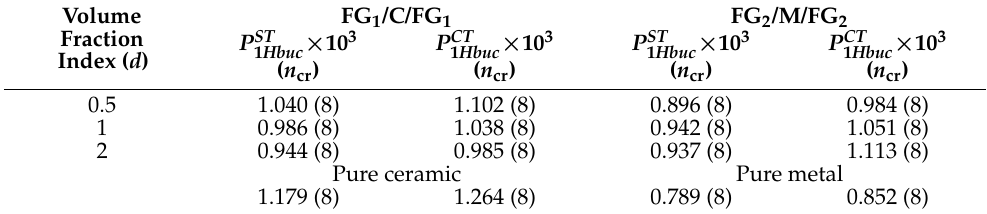
Table 5. Variations in P ST cylindrical shells versus the d